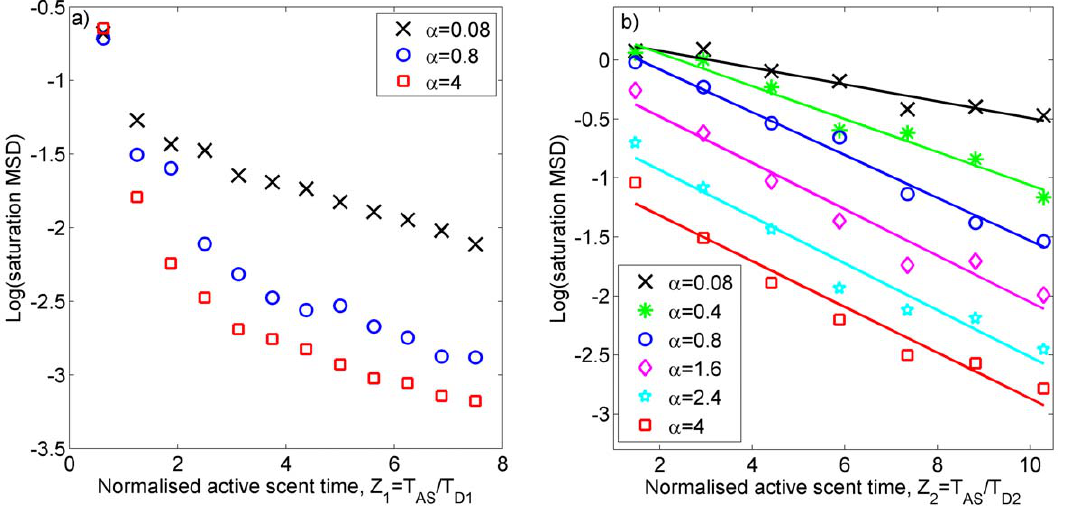
Figure 1. Simulation output for systems of territorial central place foragers. The dependence of the saturation mean square displace- 2 T (resp. D x 2 2 T ) of the dimensionless territory border position x ~ S ( x { S x ~ S ( x { S x ment (saturation MSD) D x 2 b b T ) b b T ) b ( x b ) on the dimensionless b b parameters a ~ vL = D and Z 1 ~ T AS = T D 2 ( Z 2 ~ T AS = T D 2 ) from stochastic simulation output. The notation S ... T denotes an ensemble average over stochastic simulations. The border movement is non-dimensionalised by dividing by L , the average distance between central places of adja- cent territories. Panel (a) shows output from 1D simulations and panel (b) from 2D simulations. The best-fit lines for the 2D plots are ) ~ 0 : 22 { 0 : 071 Z 2 for a ~ 0 : 08 , Log 10 ( D x 2 ) ~ 0 : 33 { 0 : 14 Z 2 for a ~ 0 : 4 , Log 10 ( D x 2 ) ~ 0 : 28 { 0 : 18 Z 2 for a ~ 0 : 8 , Log 10 ( D x 2 ) ~ 0 : 08 { 0 : 19 Z 2 Log 10 ( D x 2 b b b b for a ~ 1 : 6 , Log 10 ( D x 2 ) ~{ 0 : 54 { 0 : 20 Z 2 for a ~ 2 : 4 , and Log 10 ( D x 2 ) ~{ 0 : 93 { 0 : 19 Z 2 for a ~ 4 . b b